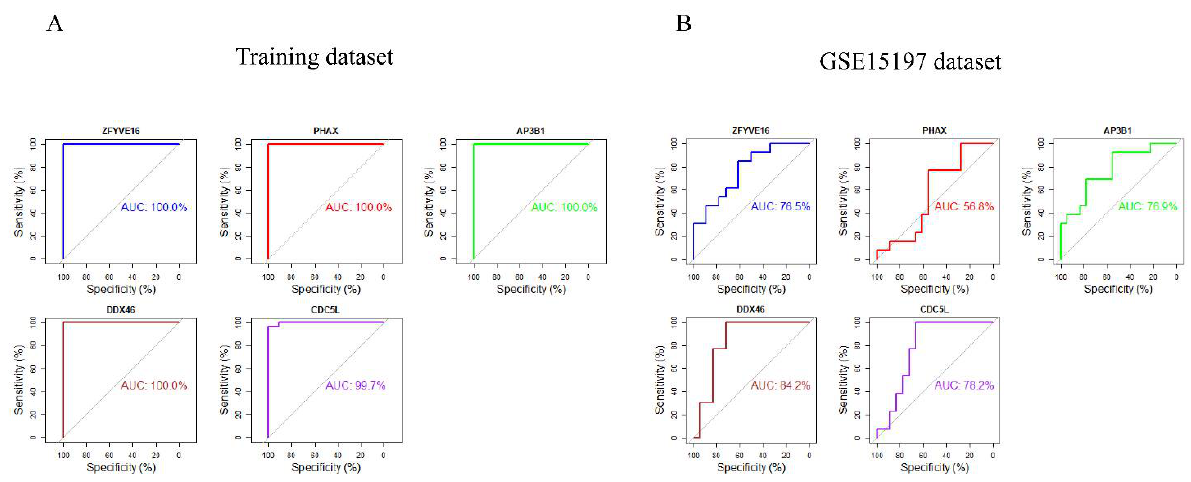
Figure 8. Validation of five candidate marker genes by ROC curve analyses. ( A ) ROC curve analysis of ZFYVE16 , PHAX , AP3B1 , DDX46 and CDC5L in the training dataset. ( B ) ROC curve analysis of ZFYVE16 , PHAX , AP3B1 , DDX46 and CDC5L in the validating dataset GSE15197.